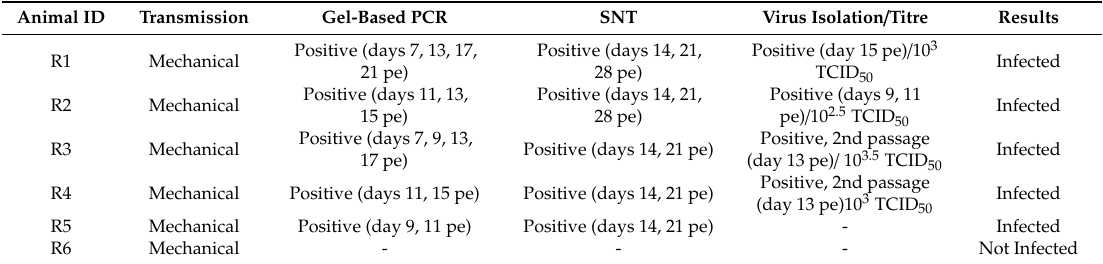
Table 3. Test results obtained from blood samples of animals R1, R2, R3, R4, R5 and